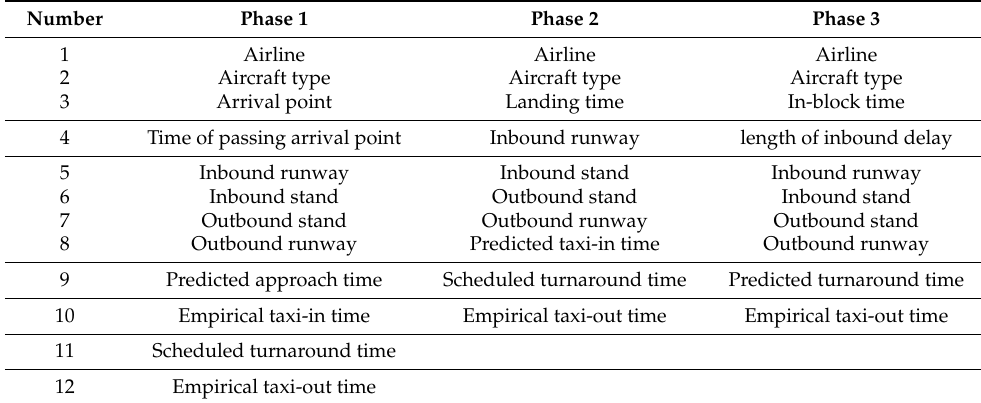
Table 6. Feature sets of the three phases of the imbalanced data classification model.